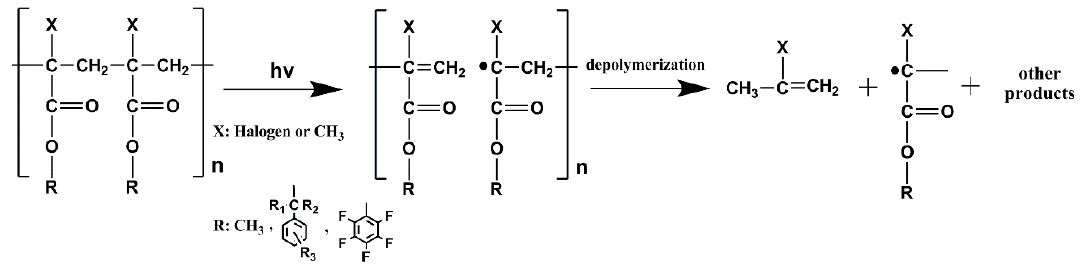
Figure 8. Example of a photodegradation mechanism for poly(methyl methacrylate) (PMMA) and its derivatives. Different atoms or groups strongly influence the properties of the corresponding resists including sensitivity and etch resistance. Irradiation of the polymer leads to the breaking of the main chain resulting to its depolymerization Adapted from [87], with permission from John Wiley & Sons, 2020.